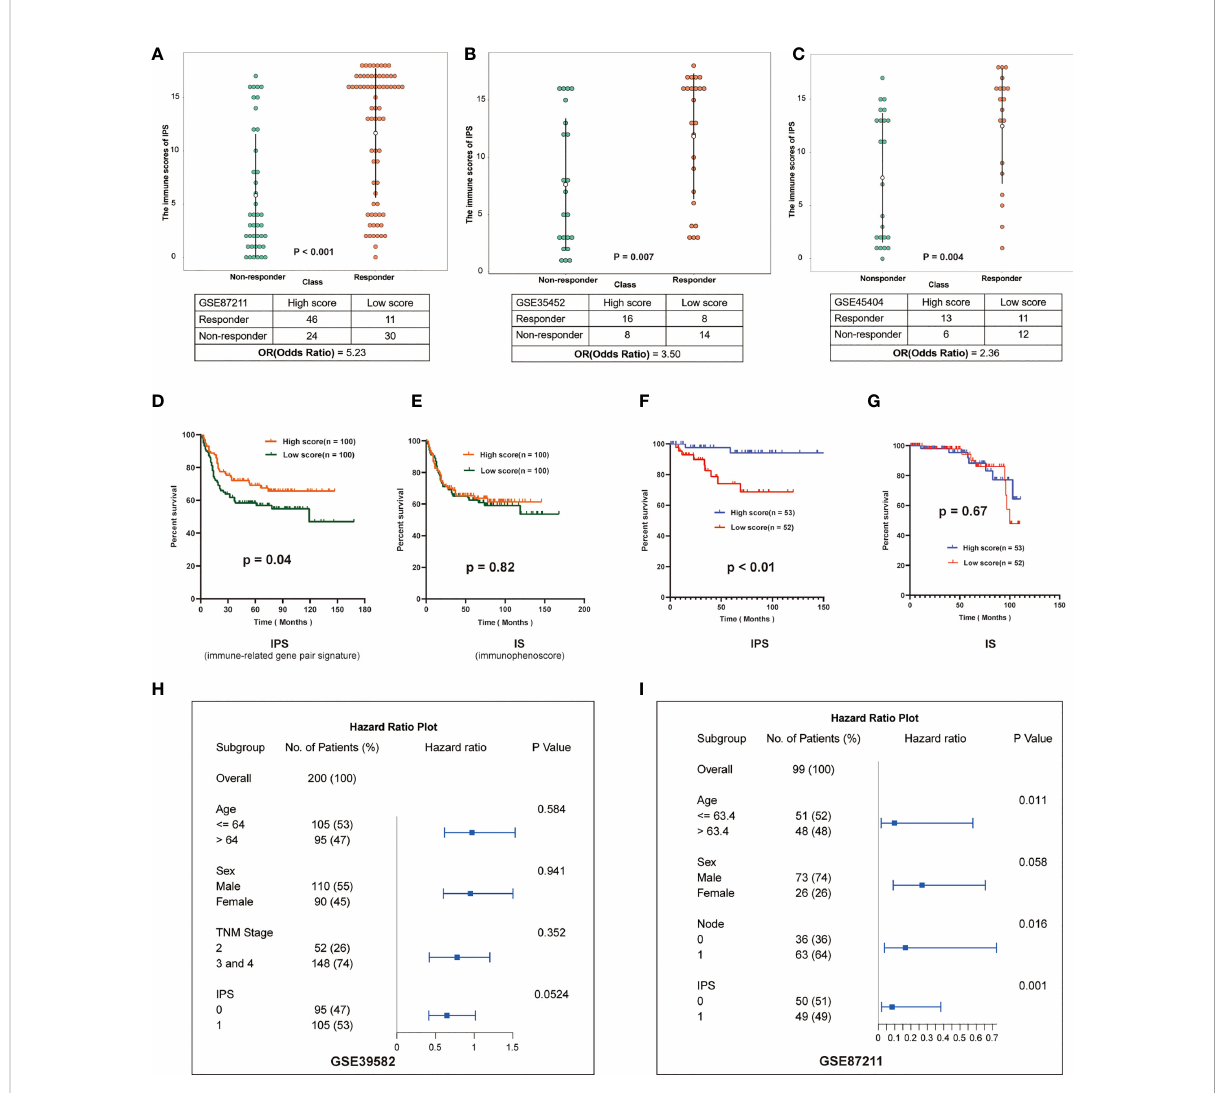
FIGURE 4 Validation of IPS in multiple datasets. (A – C) Distribution of immune scores in different groups of GSE87211, GSE35452 and GSE45404. The patients were grouped according to the response to nCRT. The abscissa represents different patient groups, and the ordinate represents the level of immune scores. (D, E) Kaplan-Meier survival curves of the DFS in the high- and low-score groups based on IPS and IS (GSE39582). (F, G) Kaplan-Meier survival curves of the DFS in the high- and low-score groups based on IPS and IS (GSE87211). (H, I) : Multivariate analysis of GSE39582 and GSE87211, hazard ratio and p-values were calculated using log-rank test. “ Node ” indicates the lymph node metastasis status of the patient before surgery, 1 indicates metastasis, 0 indicates